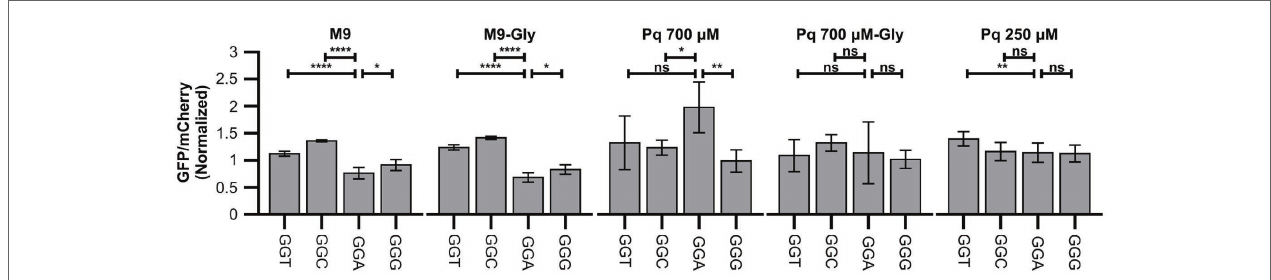
FIGURE 2 | Oxidative stress alters translation of Gly codons. Figure shows green fluorescent protein (GFP) fluorescence normalized by fluorescence of mCherry in diverse strains and conditions. Data were additionally normalized dividing by the GFP/mCherry ratio of the control strain (reporter S1, without additional codons). Four identical Gly codons were cloned in fusion to GFP and fluorescence measured in control media (M9), control media with Gly (M9-Gly), media with high concentration of paraquat in the absence (PQ 700 μ M) or presence (PQ 700 μ M-Gly), or media with low concentration of paraquat (PQ 250 μ M). **** p ≤ 0.0001, ** p ≤ 0.01, * p < 0.05, one way ANOVA with Dunnett versus GGA strain for each condition ( n ≥